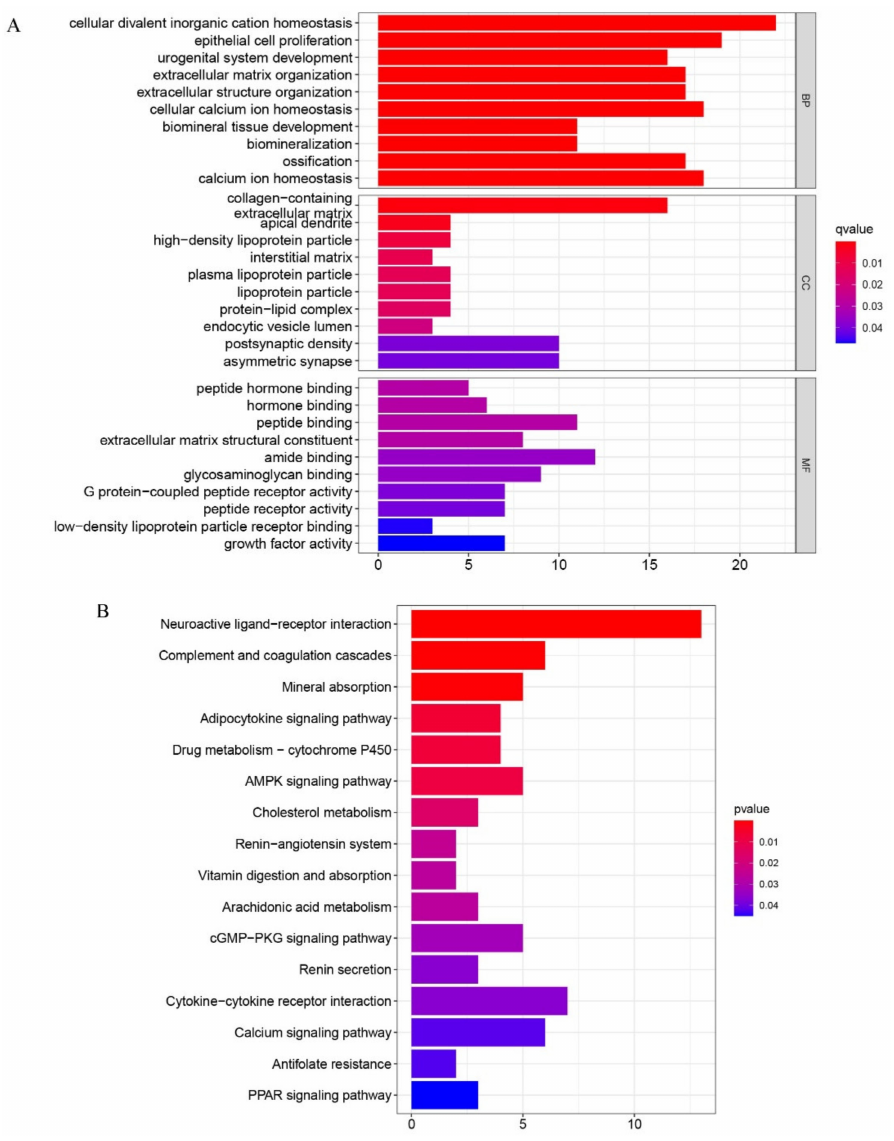
Figure 3. ( A ) Gene Ontology (GO) analyses were conducted to predict the potential function of the differentially expressing genes between the treat and the control group including cellular component (CC), molecular function (MF), biological process (BP), respectively. ( B ) Kyoto Encyclopedia of Genes and Genomes (KEGG) predicted the potential pathways regarding the differentially genes between the treat and the control